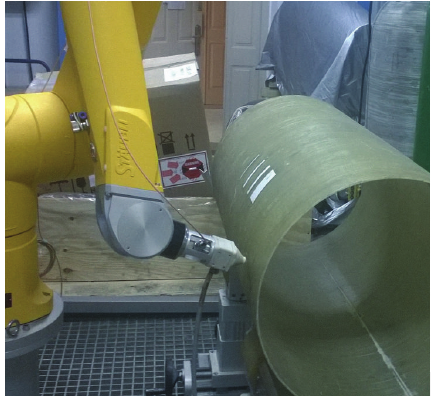
Figure 7: Robotic ultrasonic testing